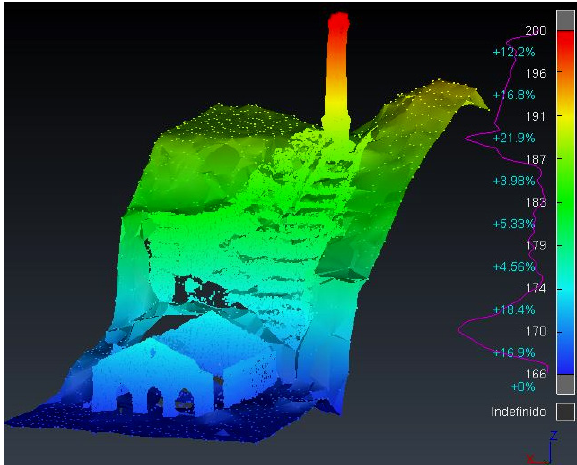
Figure 6: Thematic model according to heights (source: